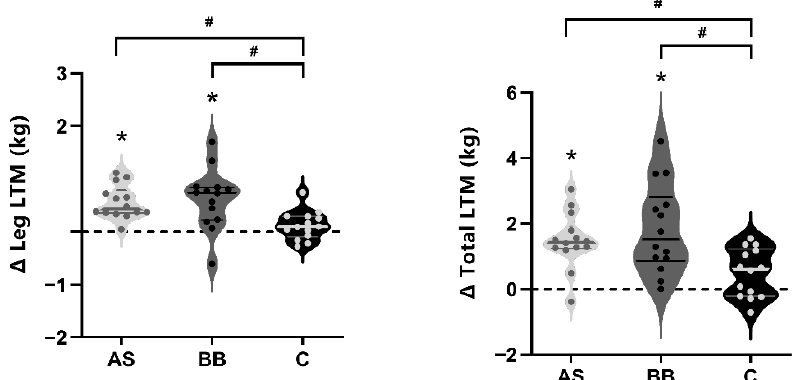
Figure 3. The violin plots of changes in leg muscle and total lean mass in AS, BB, and C group after 6-week intervention. The thick solid lines indicate the mean value of changes of each group, and the thin solid lines indicate interquartile range. An asterisk (*) indicates the change of the index is significant ( p < 0.05). A pound sign indicates the difference between groups is significant ( p < 0.05). A pound sign (#) indicates the difference between groups is significant ( p < 0.05).